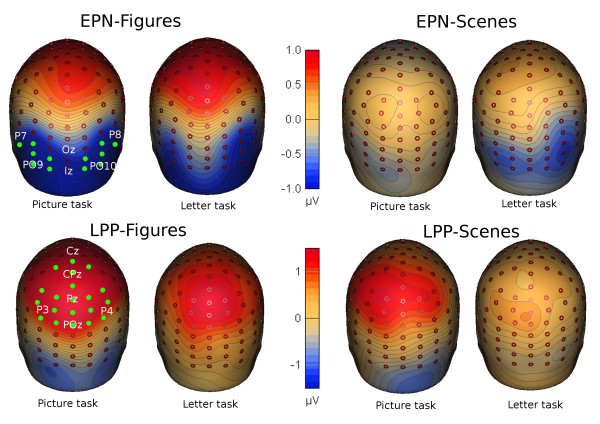
Topographies of the main effect of emotion (negative minus neutral) for the EPN across 200–280 ms (top row) and for the LPP across 400–700 ms (bottom row). Topographies for picture and letter tasks are shown for figures (left) and for scenes (right). The relevant electrodes (green) in computing the mean amplitudes are shown together with common 10/20 electrode positions (white)